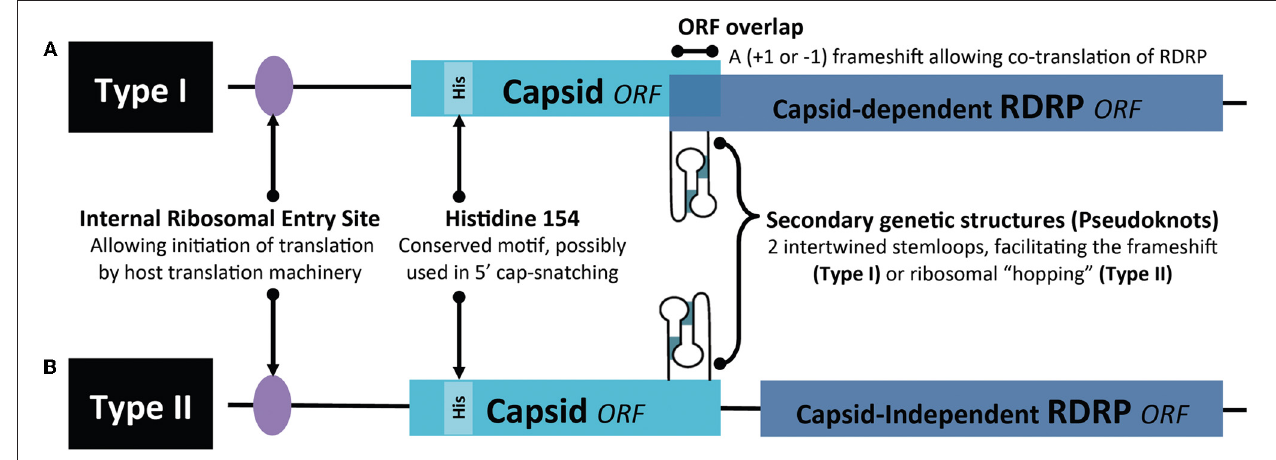
FIGURE 2 | Organization of the Totiviridae genome. (A) Type I represents the classic capsid-dependentorganization with overlapping ORFs, where a − 1 or + 1 frameshift (under the control of a pseudoknot structure) allows for